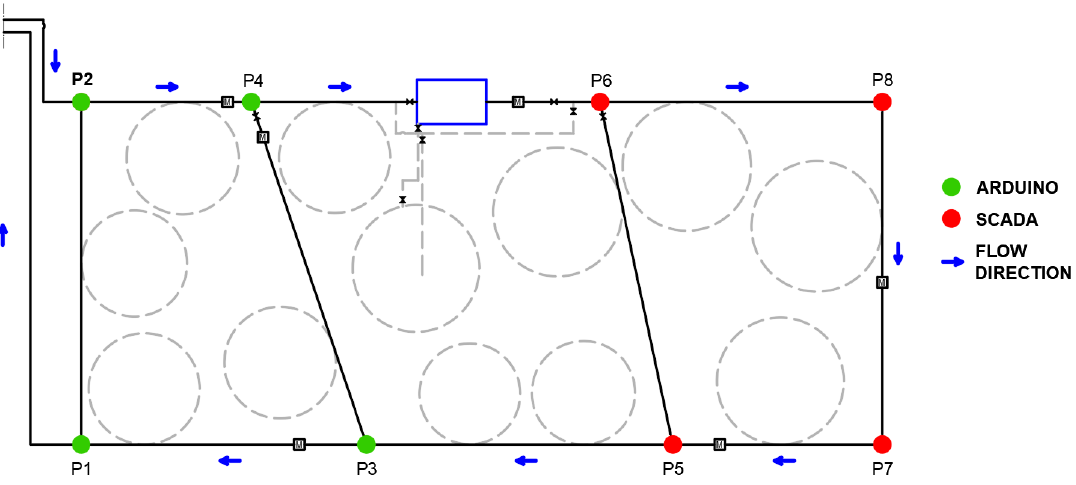
Figure 5. Network